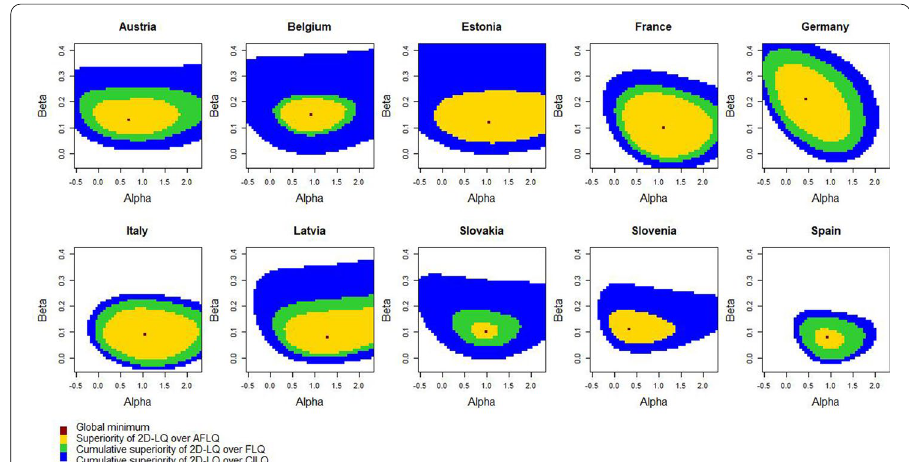
Fig. 6 Mapping for ten EA‑19 countries in 2015